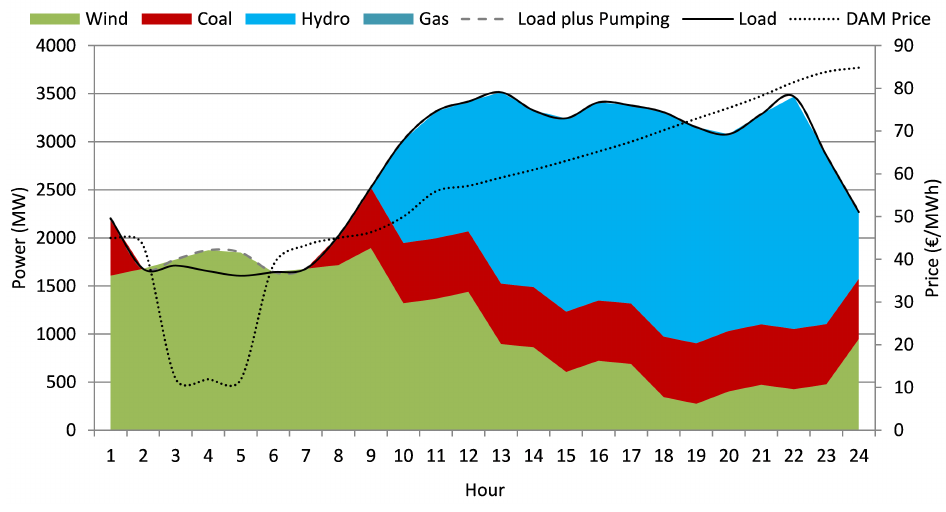
Figure 7. Day-ahead market